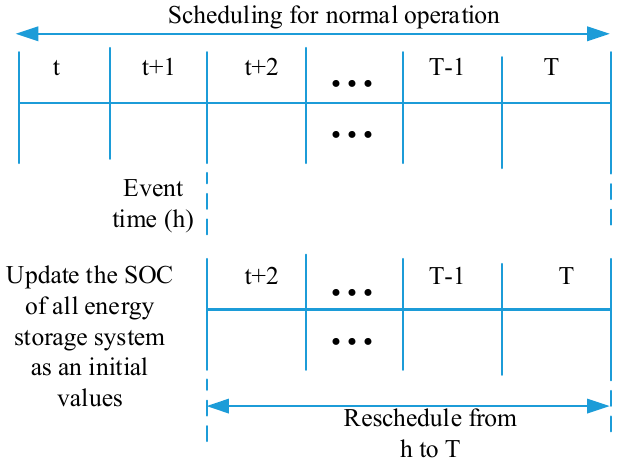
Figure 4. Rescheduling of the CCHP system with an event time.